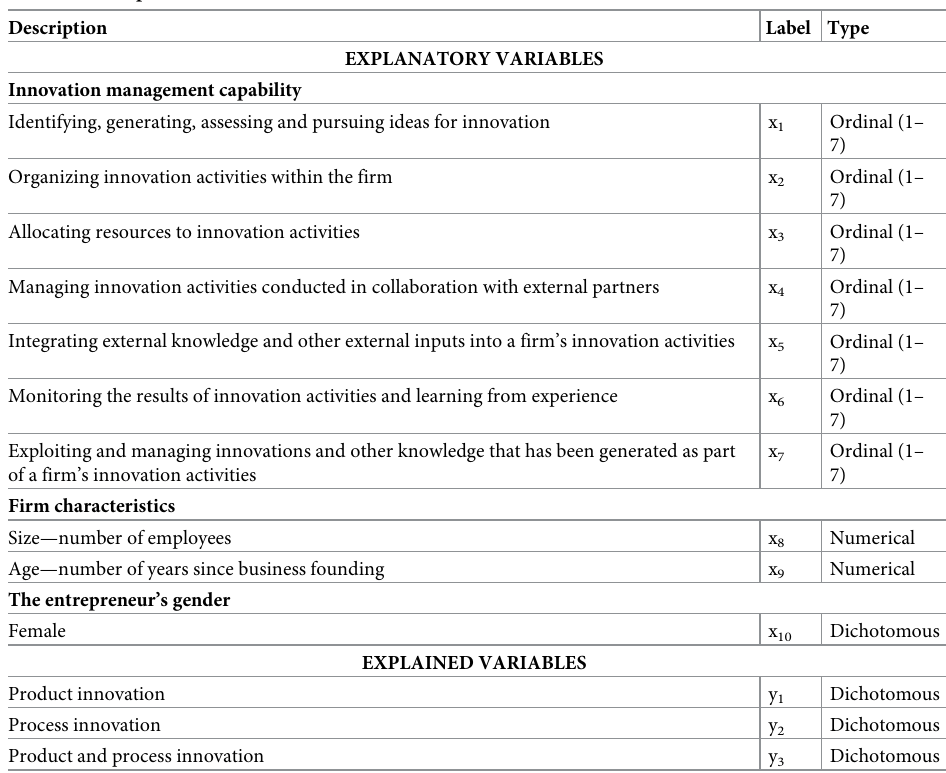
Table 2. Description of